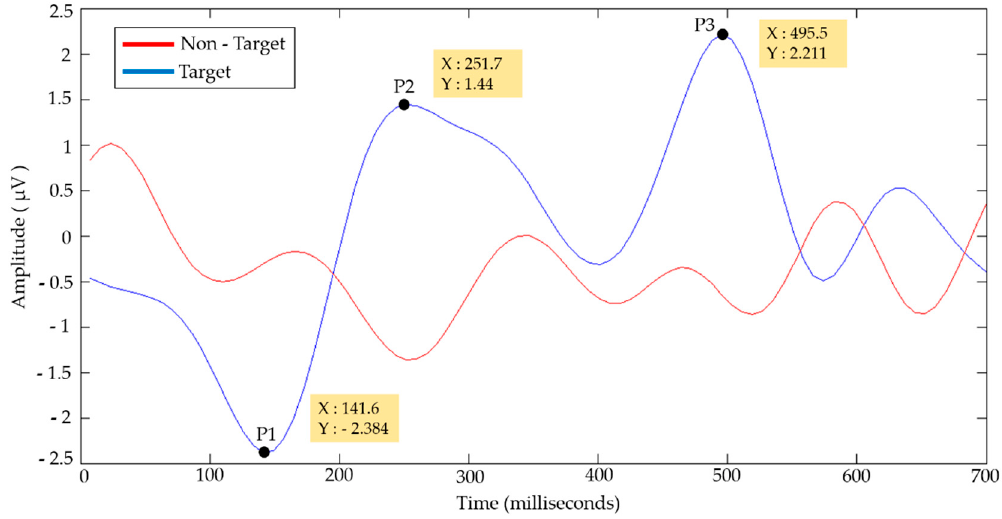
Figure 5. Average EEG signals for the two conditions (Target/Non-Target).